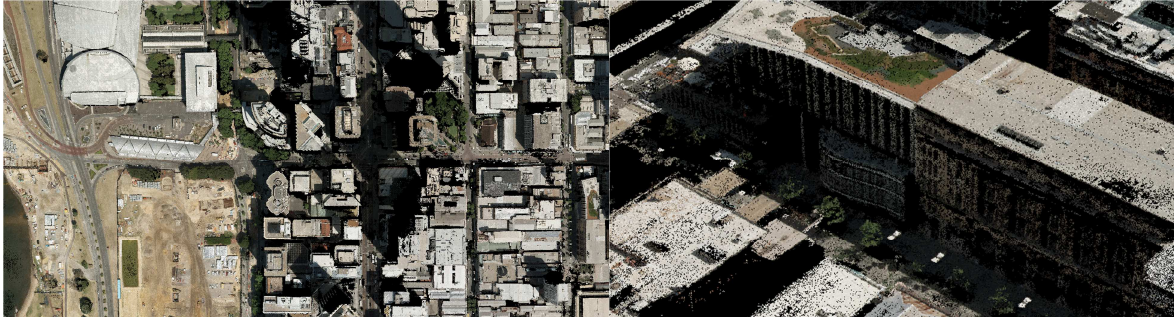
Fig. 4: Perth - airborne image dataset. Left: result overview, right: detail. Pointcount: 394 Mio. points before, 73 Mio. points after filtering with fold 2. Time: ~24 Minutes (no SSD). Imagery kindly provided by Aerodata International